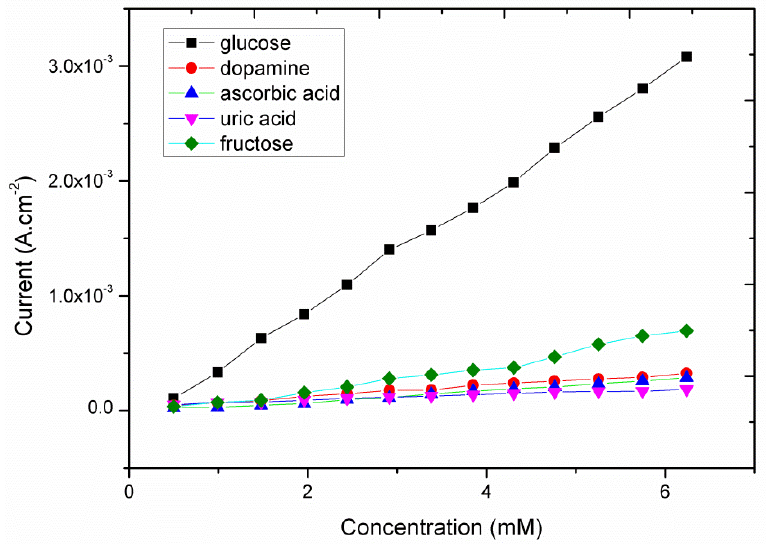
Figure 7. The calibration curve of the proposed glucose sensor in the presence of common